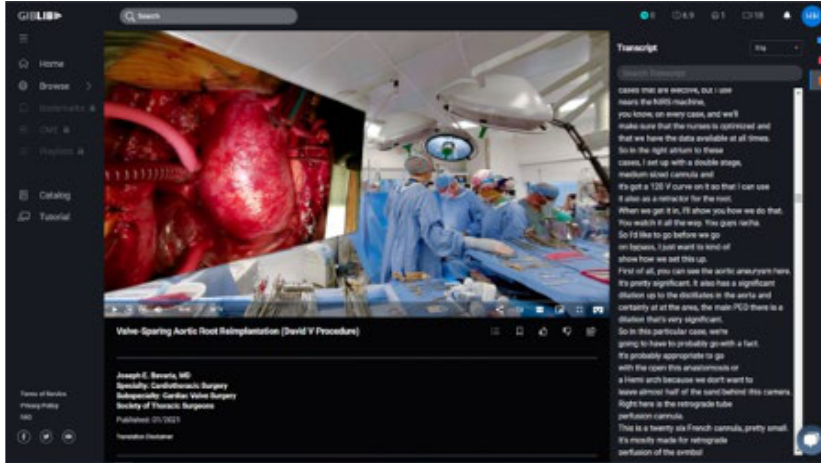
Figure 2 Screenshot of a 360VR surgery video with transcript